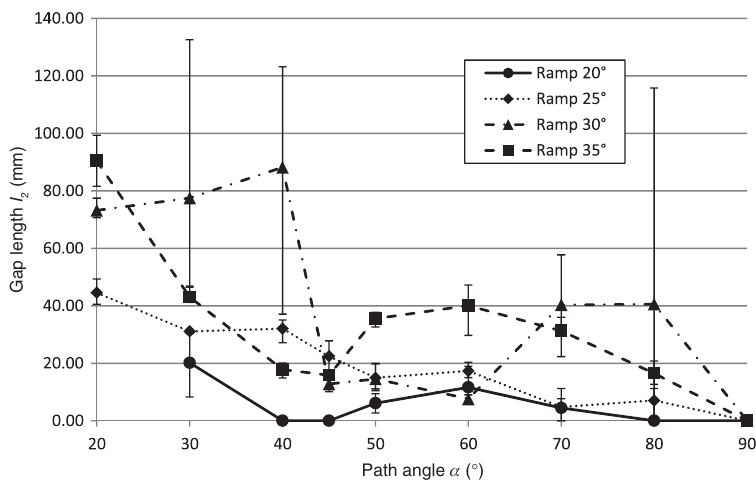
at the bottom plane. 1